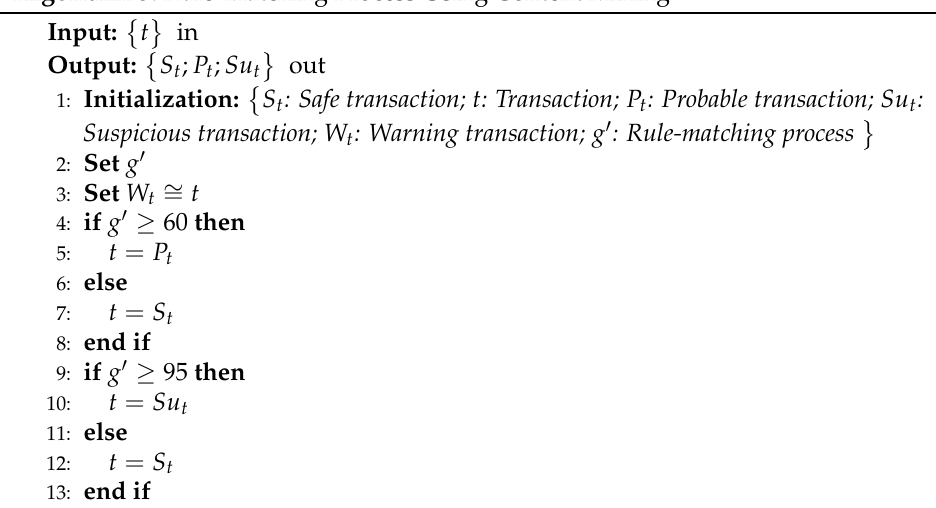
Algorithm 3: Rule-Matching Process Using Content